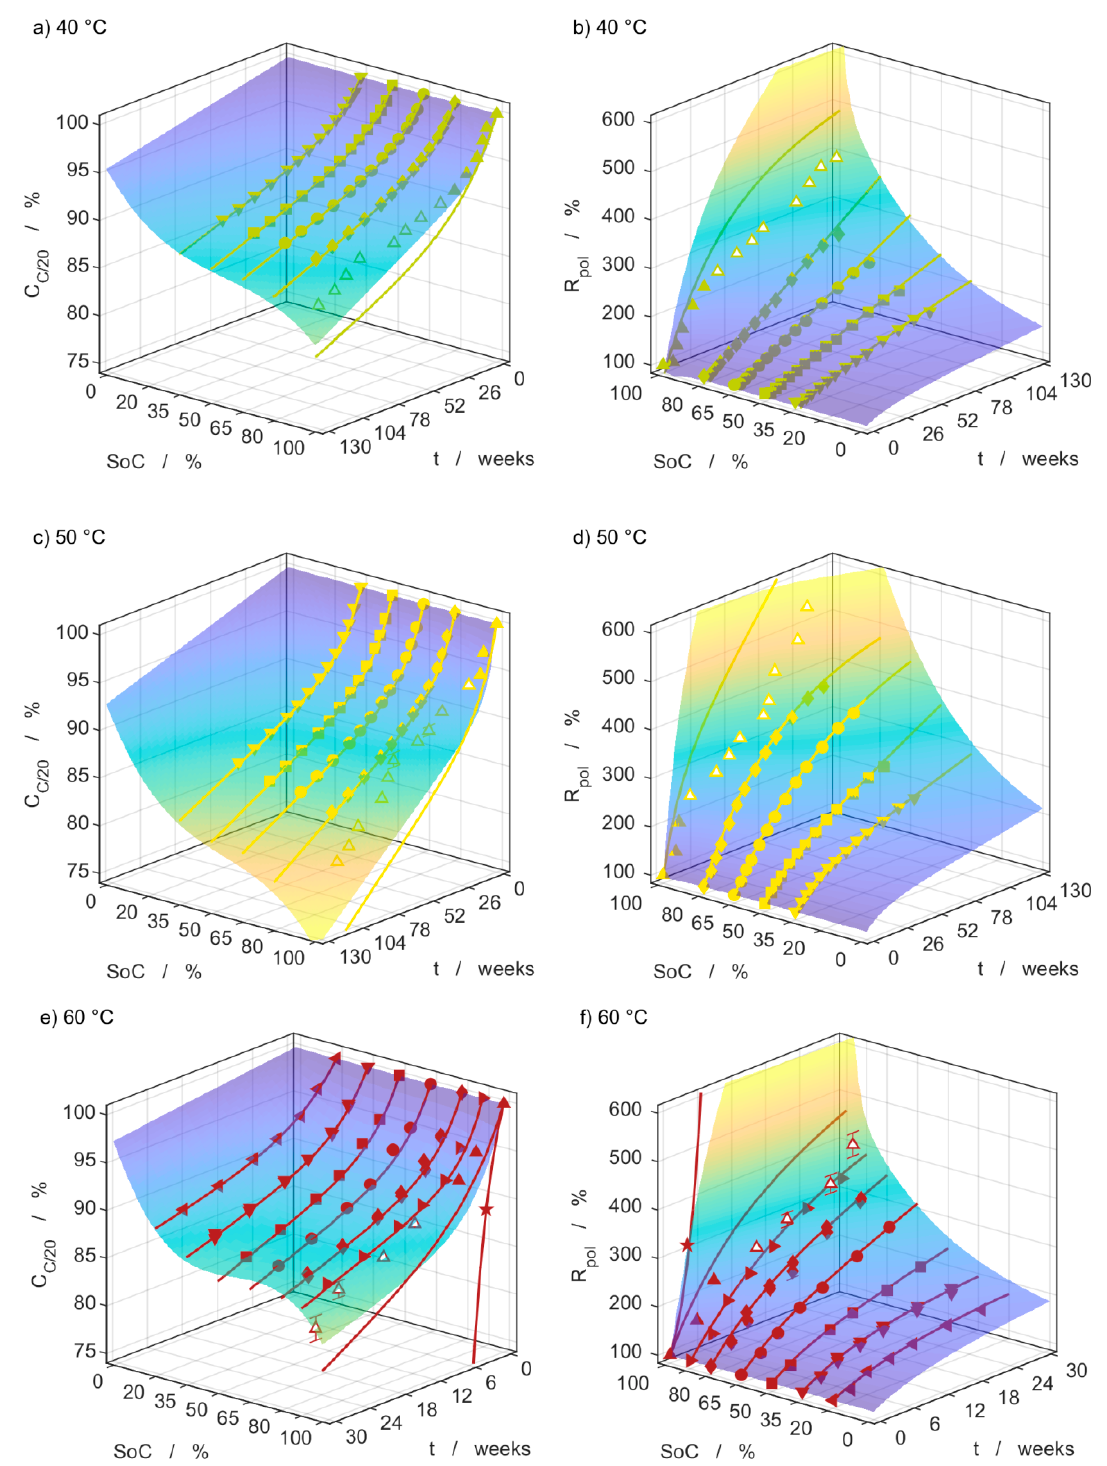
Figure 6. Discharge capacity fade (left column, ( a , c , e )) and increase in polarization resistance (right column, ( b , d , f )) as a function of SoC and time for the three temperatures of 40 °C, 50 °C and 60 °C (from top-down). The markers indicate intermediate cell characterizations, the lines the 2D fit, and the plane the SoC dependency of the 4D fit.